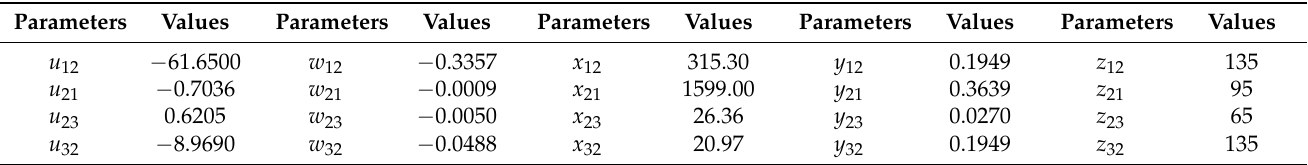
Table 2. Parameters of the transfer functions of feed-forward decoupling